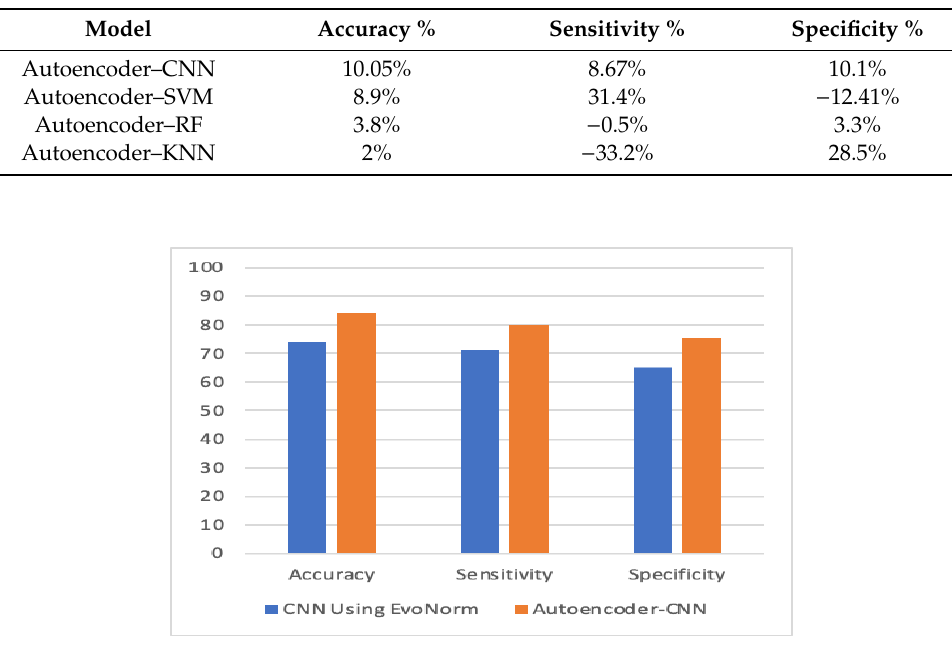
Figure 12. Autoencoder-RF vs. RF. Figure 13. Autoencoder-KNN vs. KNN.